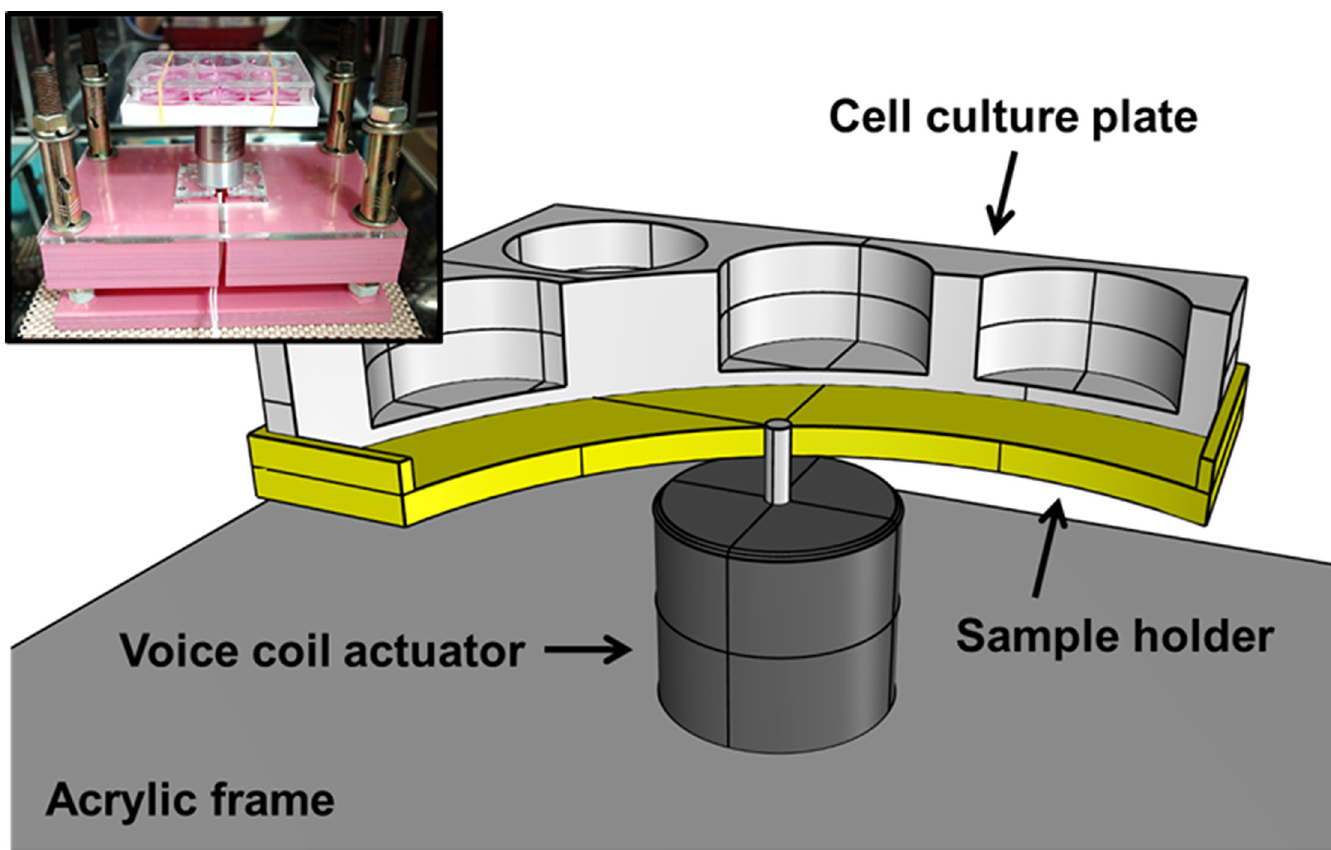
Fig 1. Schematic design and photographic image of the vibrational culture model. The culture model is composed of an acrylic frame, a voice coil actuator (VCA), a sample holder, and a digital servo driver. The acrylic frame with the VCA and the sample holder are located inside the CO 2 incubator, while the digital servo driver connected to the DC power supply and the laptop computer are located outside the